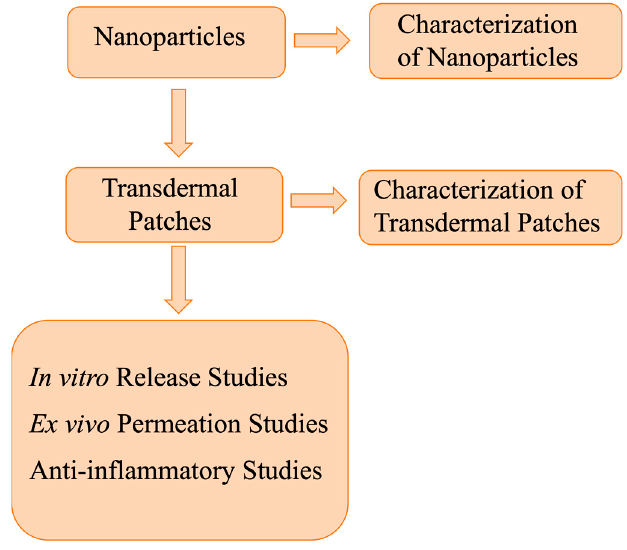
Figure 5. Scheme of the experimental procedure.